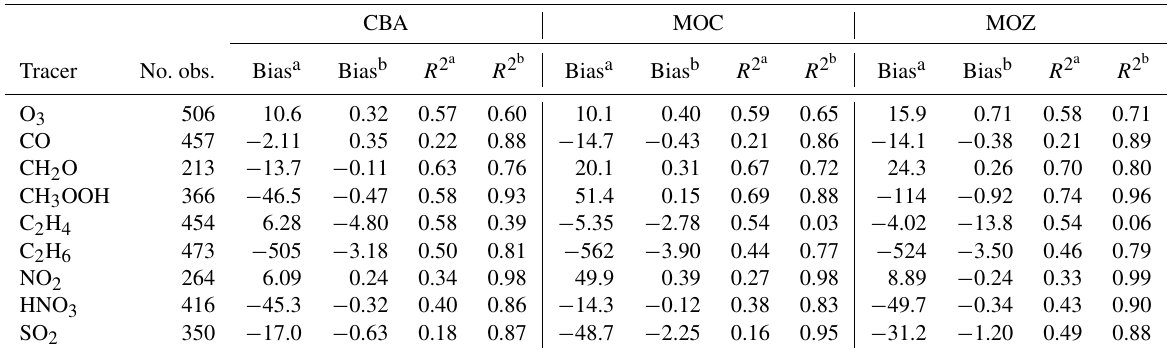
Table 4. Summary of the bias and correlation coefficients (in terms of explained variance, R 2 ) of model results versus all available aircraft observations, also weighted with relative uncertainties. Bias: model results minus observations.